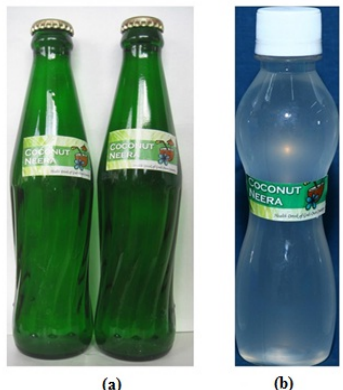
Figure 4. Bottled pasteurized coconut Neera: ( a ) Neera filled in glass bottles of 300 mL capacity and ( b ) Neera filled in polypropylene (PP) bottles of 200 mL capacity.